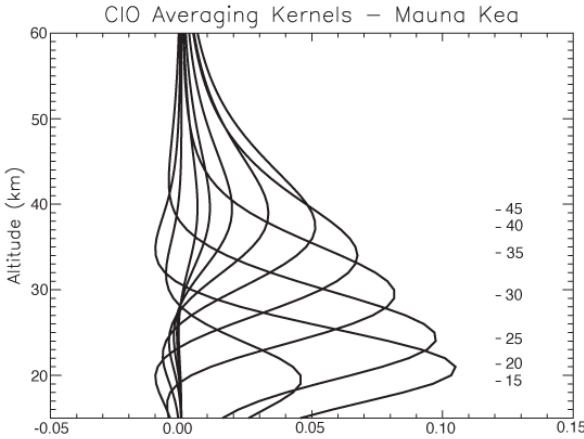
Fig. 4. Change in ClO between 2009 and 2010, with and without the revised analysis.